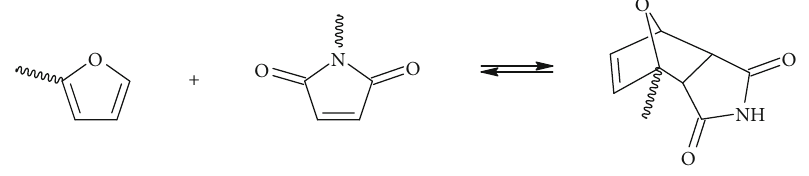
Figure 14: Representation of a general Diels-Alder reaction. Table 3: Types of fi llers and their roles within the polymer